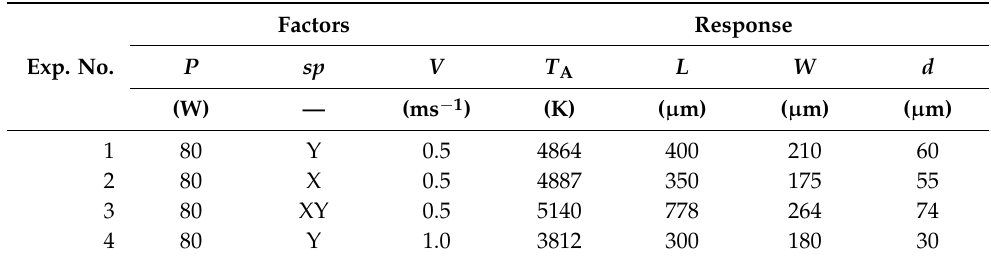
Table 2. L 27 Orthogonal array and response